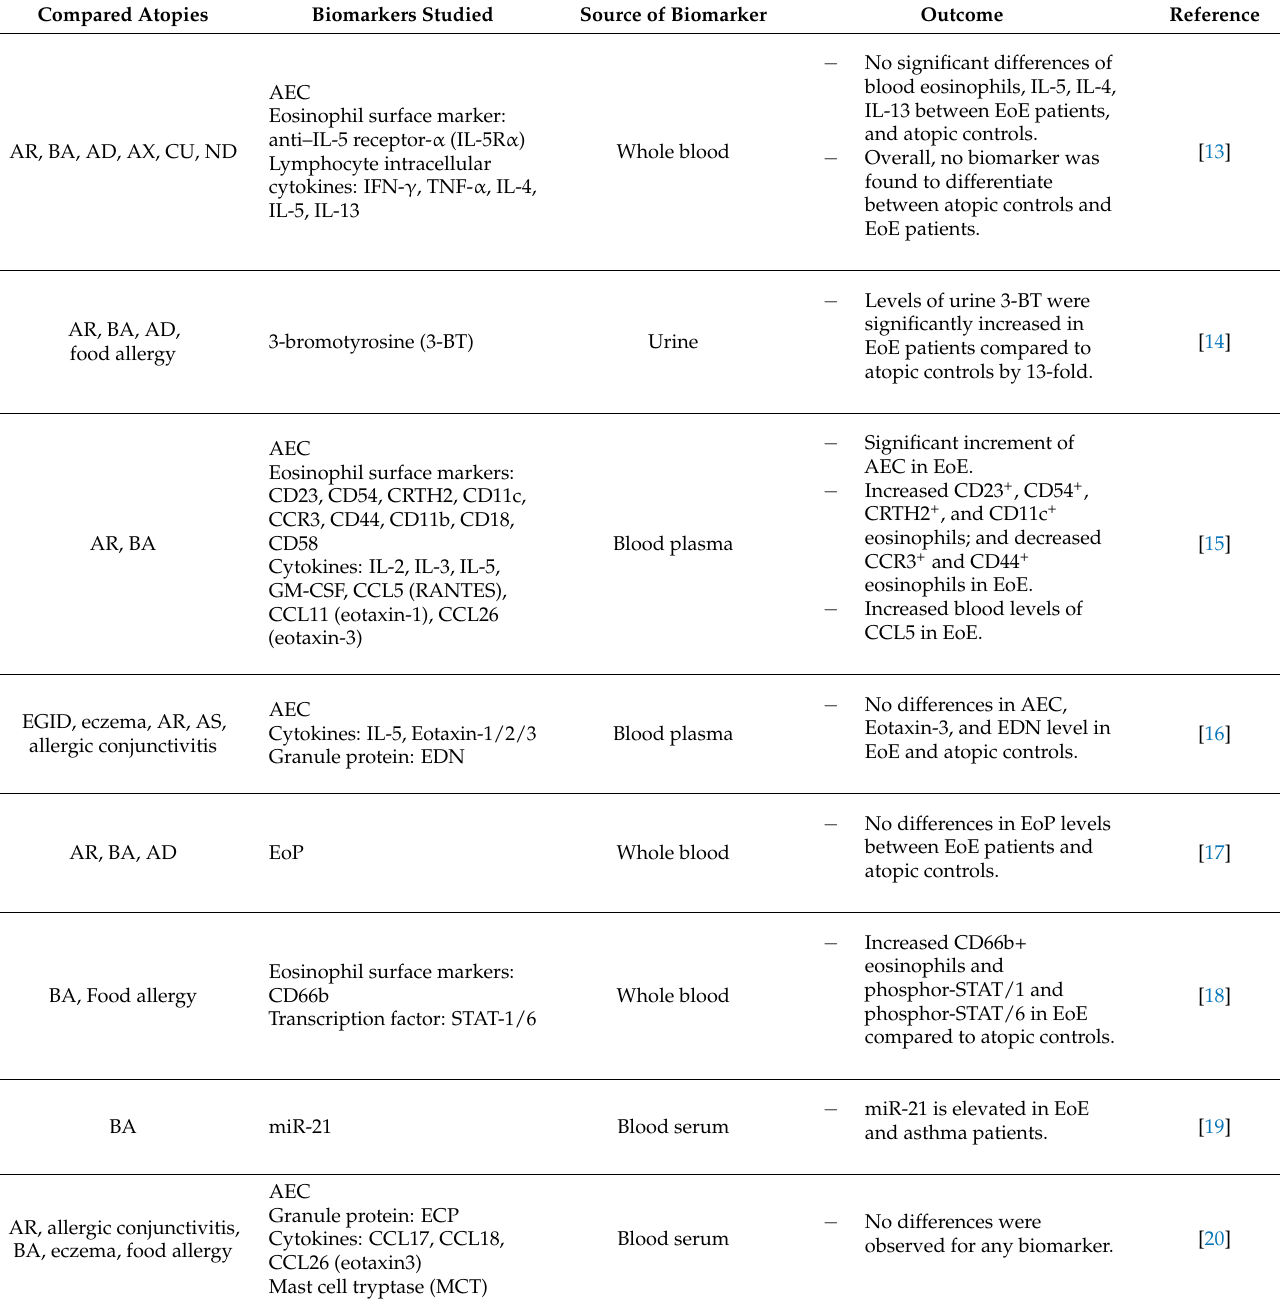
Table 1. Research studies including atopic control groups. AEC: absolute eosinophil count, AR: allergic rhinitis, BA: bronchial asthma, AD: atopic dermatitis, AX: food anaphylaxis, CU: contact urticaria, ND: non-determined, EGID: eosinophilic gastrointestinal disorders, EDN: eosinophil- derived neurotoxin, EoP: eosinophil